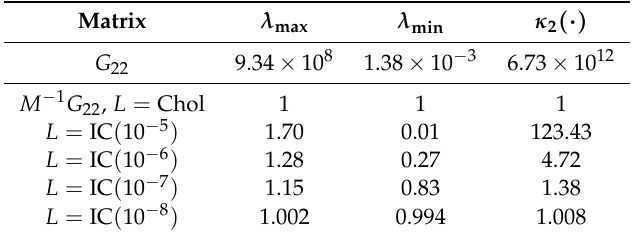
Table 2. The largest and smallest magnitude eigenvalues and the condition numbers for matrix G 22 and preconditioned G 22